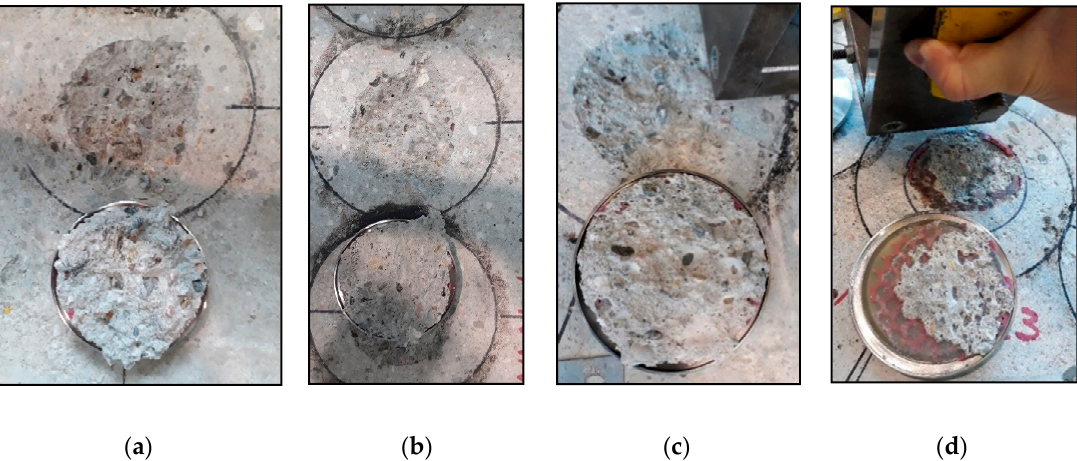
Figure 7. Failures of type a plate in uncracked shear ( a ), type b plate in the uncracked tension test ( b ), ( c ) type a plate in